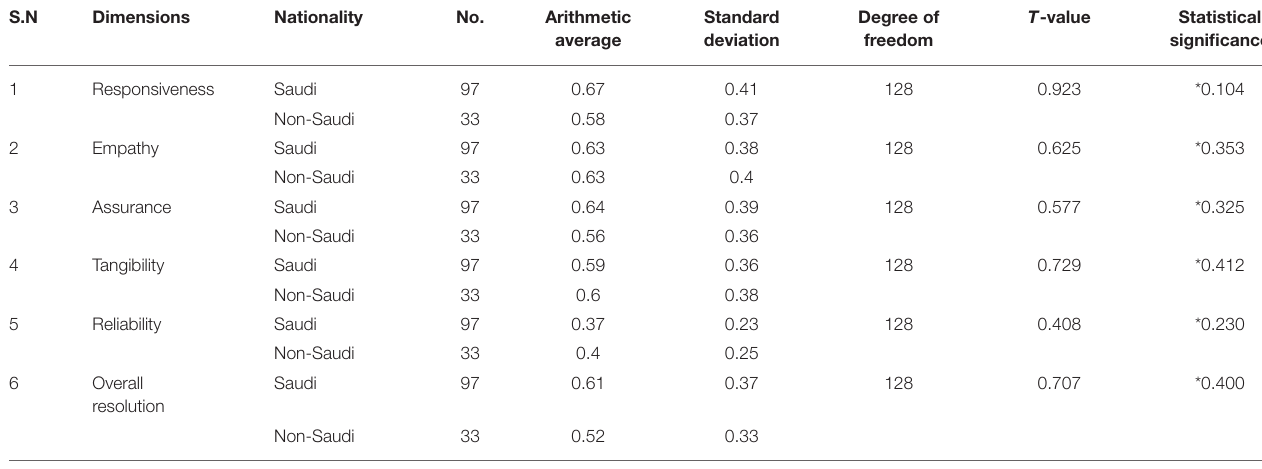
TABLE 6 | T -test shows differences in the sample individuals’ responses according to the nationality variable by calculating the gap. S.N